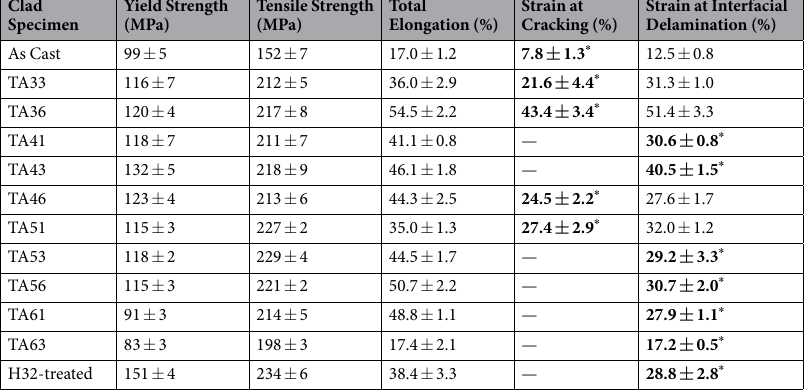
Table 1. Room-temperature tensile properties of the twin-roll-cast Ti/Al clad specimens. * Effective ductility.